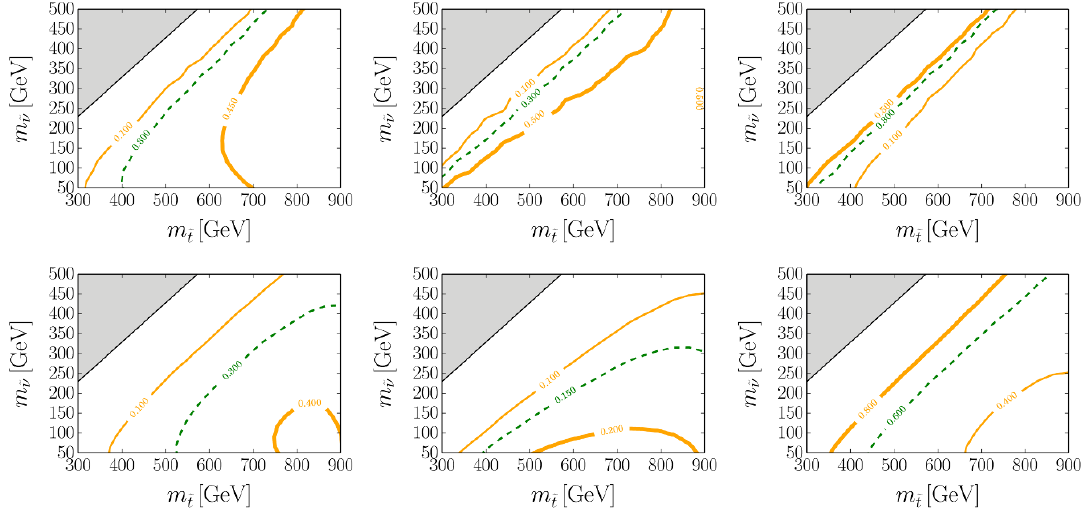
Figure 5 . Contour plots of the values of BR( e t ! t and BR( e t ! b (cid:23)(cid:28) ) (right panels) in Scenario A (upper panels) and Scenario B (lower e